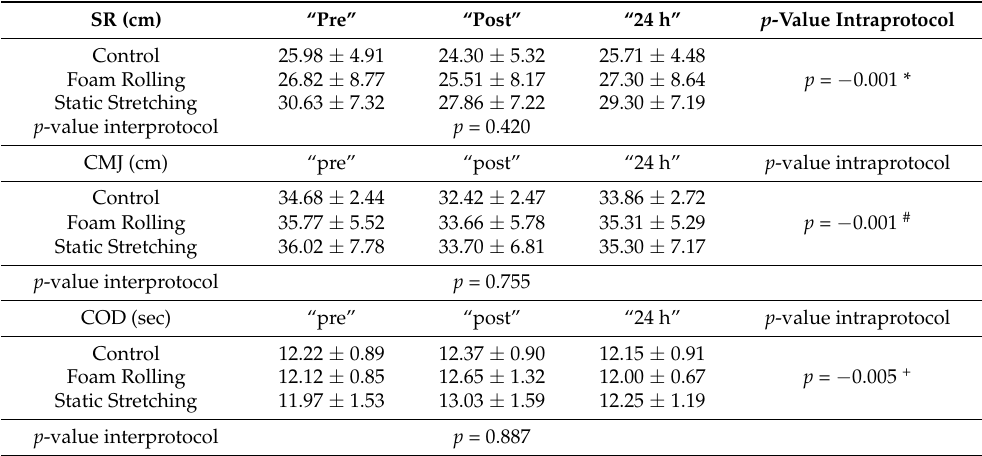
Table 3. Outcomes of the SR, CMJ, and COD presented as mean and standard